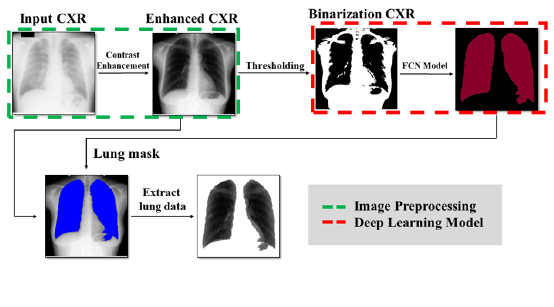
Figure 1. Flowchart of the proposed pre-processing